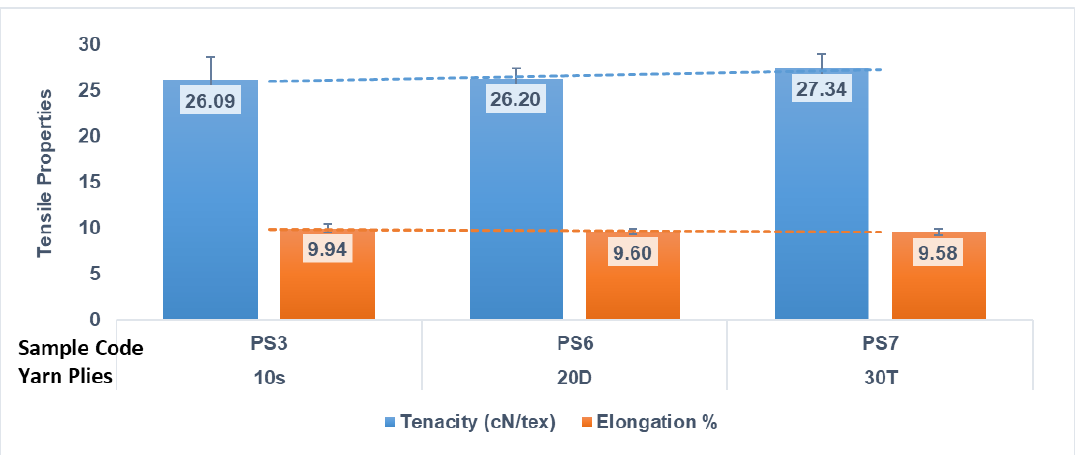
Figure 4. Effect of yarn plying and twisting on tensile properties of MFHSYs.